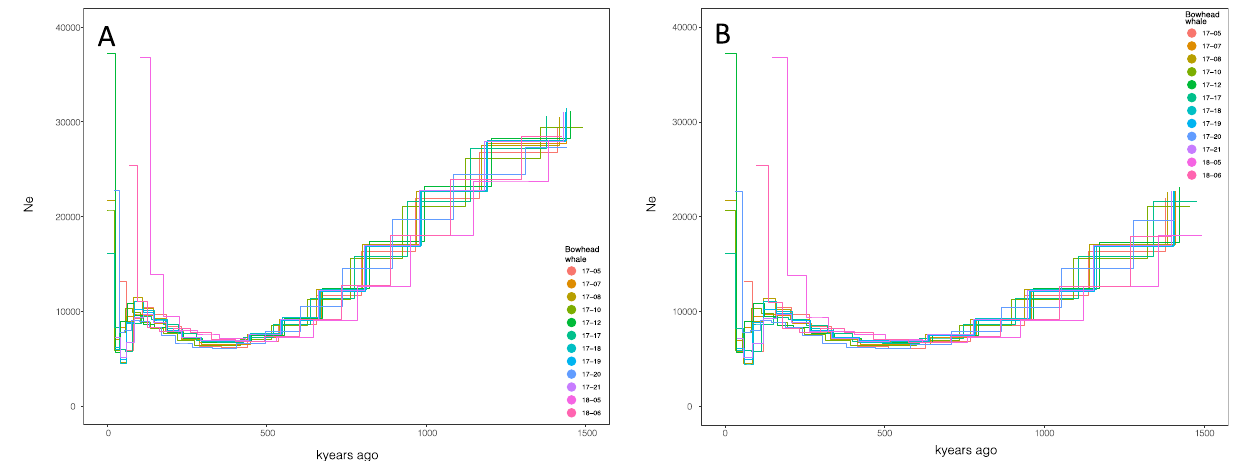
Figure 5. PSMC demographic analysis model outputs for 12 bowhead whales from the EGSB reaching back 1.5 million years. ( A ) using a generation time of 35 years. ( B ) using a generation time of 50 years.